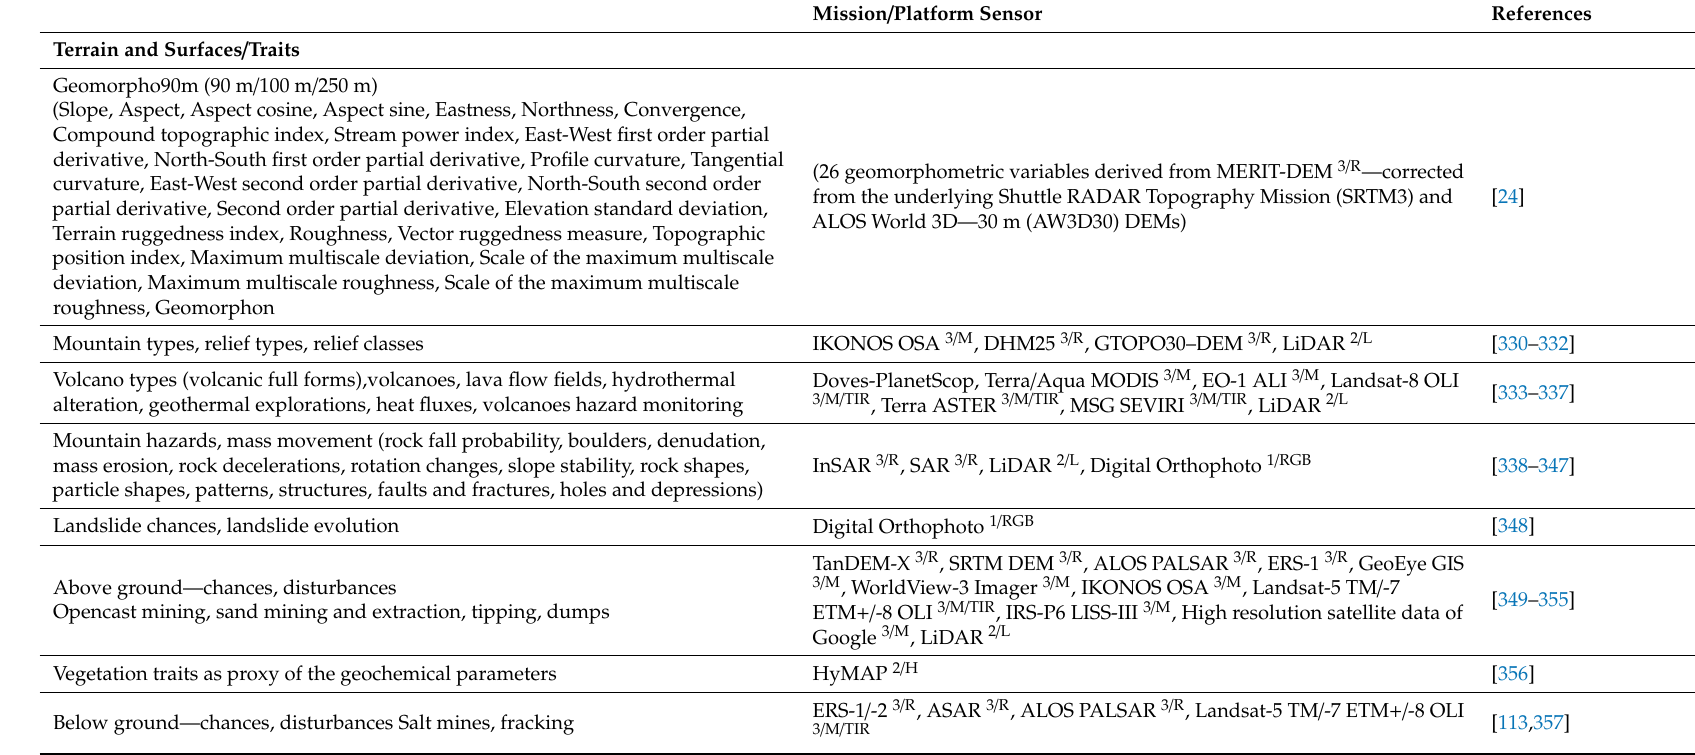
Table 5. Remote sensing (RS)-aided derived in monitoring examples in terrain and surfaces, aeolian geomorphology, fluvial geomorphology and coastal geomorphology landslides and their